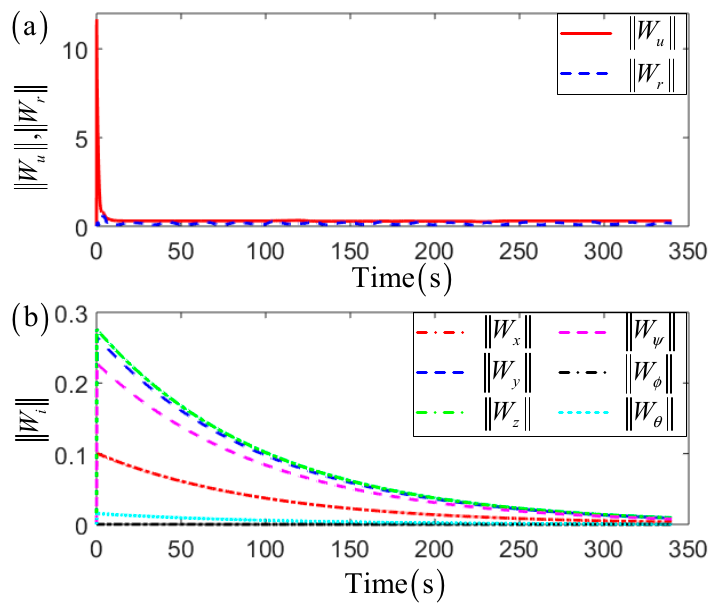
Figure 8. The position and heading errors for the USV-UAV (( a ) is heading errors for USV-UAV. ( b ) is position errors for USV-UAV.).